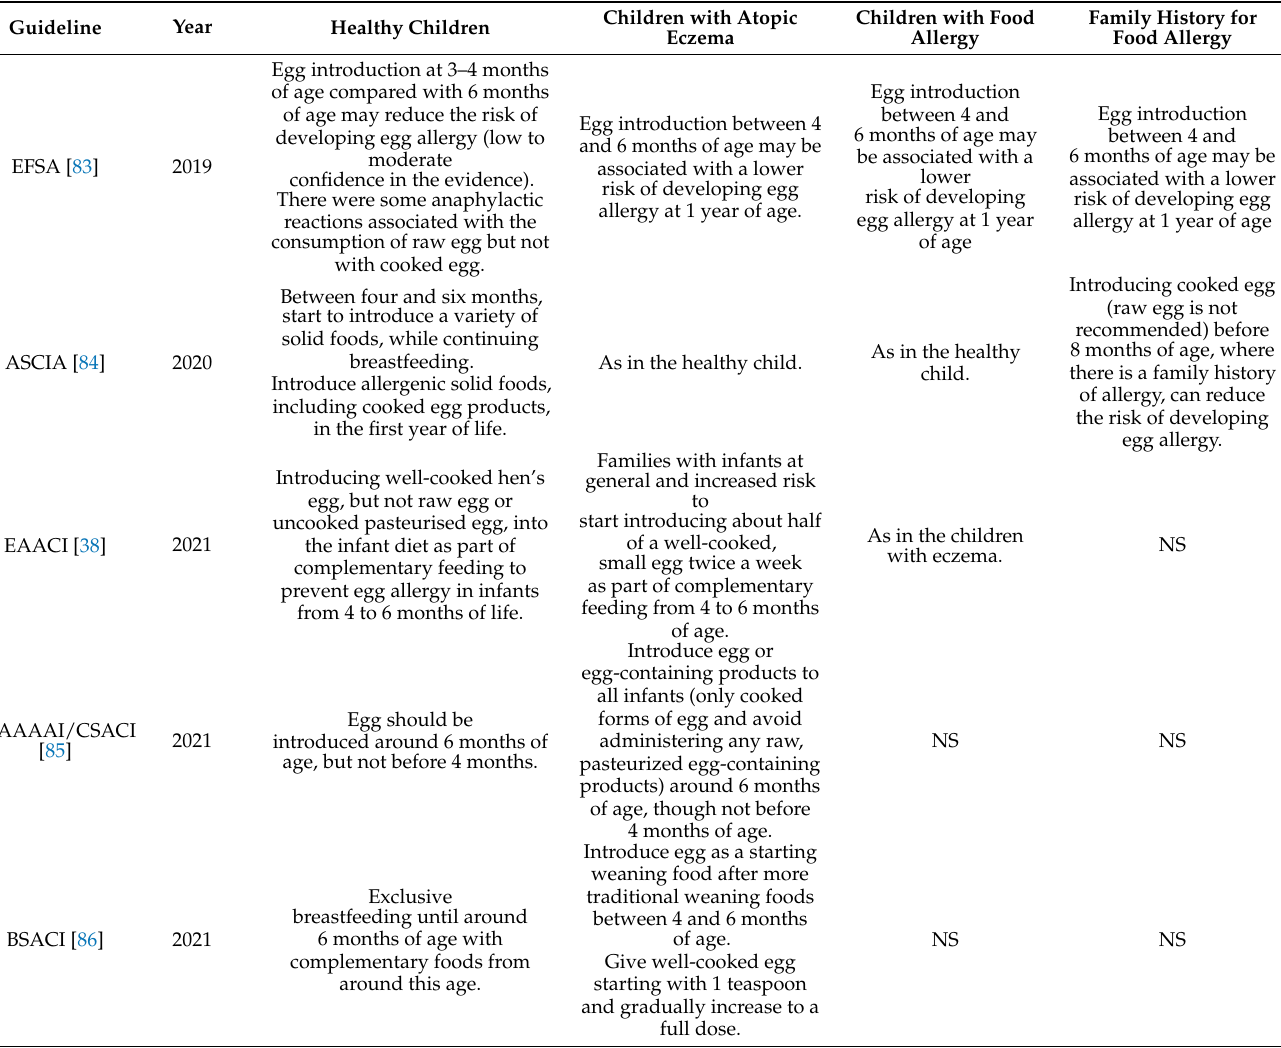
Table 4. Guidelines on dietary interventions for preventing egg allergy.